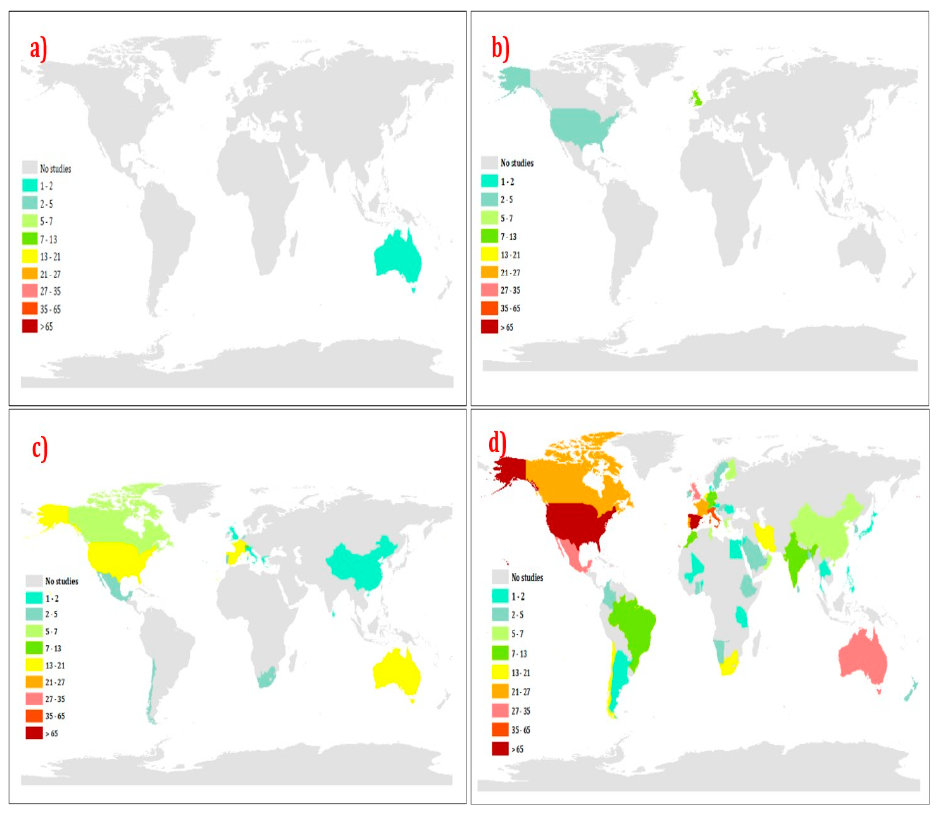
Figure 3. Contributions: ( a ) 1981–1990; ( b ) 1991–2000; ( c ) 2001–2010; ( d ) 2011–2020. Country collaboration during the 1980s was noted only for Australia. This research